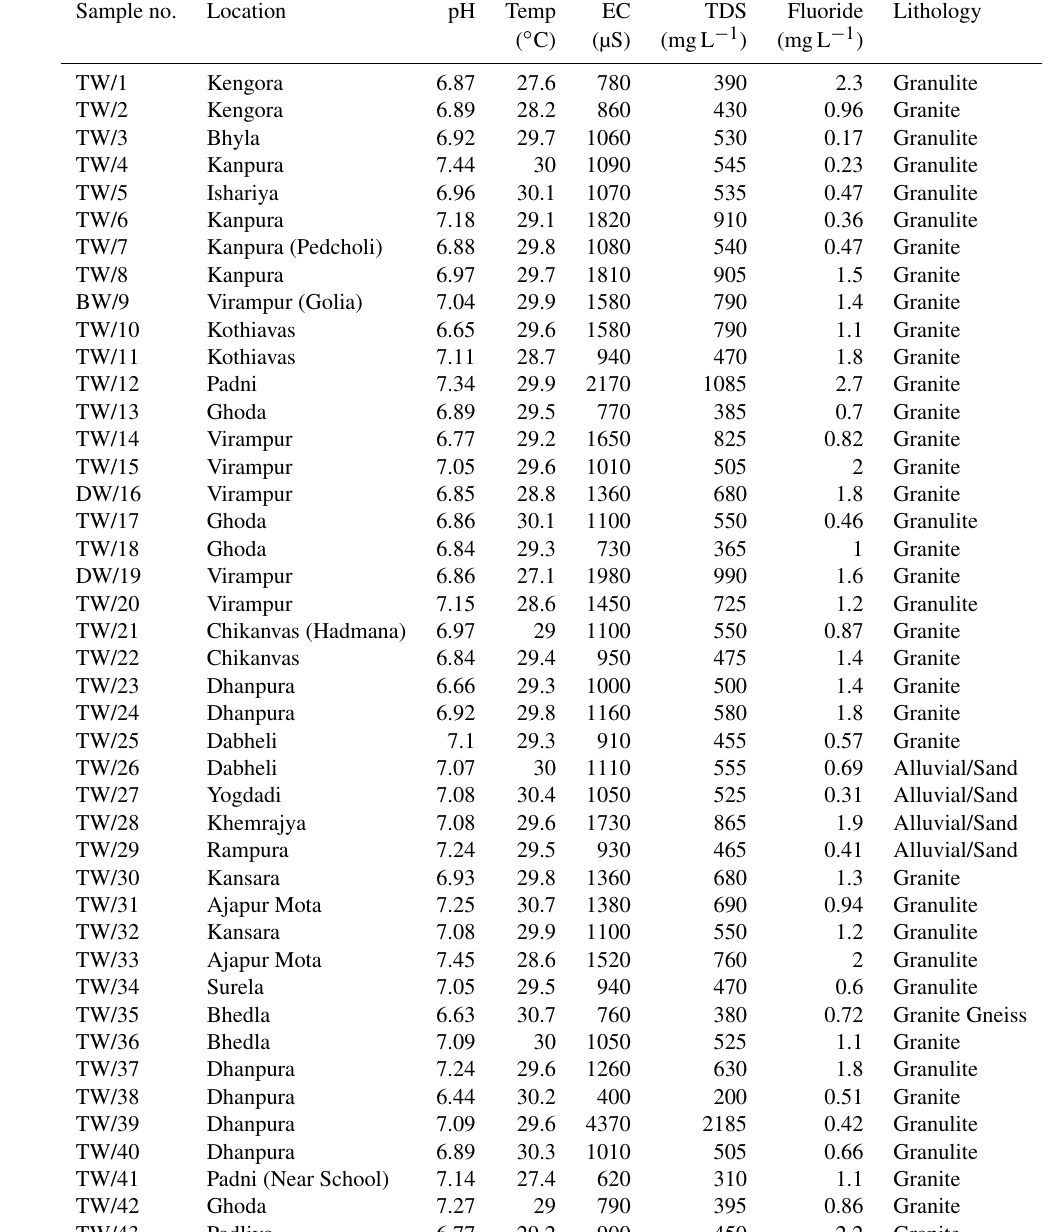
Table 1. Physical and chemical analysis of groundwater of Ambaji region, North Gujarat, India. Sample no.